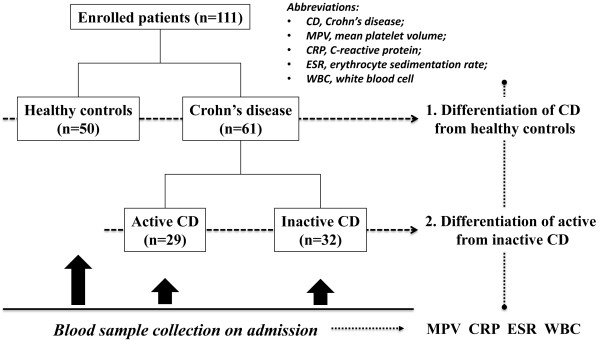
Study design. A total of 111 subjects were enrolled in the current study. Fifty healthy controls were differentiated with 61 Crohn’s disease (CD) patients using mean platelet volume (MPV), C-reactive protein (CRP), erythrocyte sedimentation rate (ESR) and white blood cells (WBC). Furthermore, the 61 CD patients were divided into active (n = 29) and inactive (n = 32) groups and distinguished using the same inflammatory biomarkers. All blood sample collections were obtained on admission (before any medication or procedure).